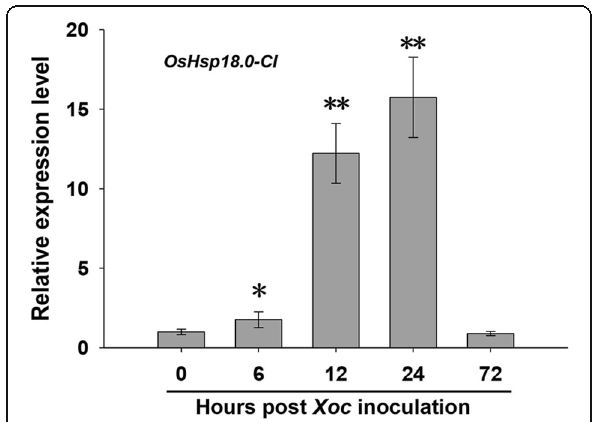
Fig. 1 OsHsp18.0-CI is induced by Xoc inoculation. The expression level of OsHsp18.0-CI in response to RS105 in Shengdao806 at 0, 6, 12, 24 and 72 h post inoculation. The bars represent the means (three replicates for gene expression) ± SD. The significance of expression compared to 0 h at P values of less than 0.05 and 0.01 are marked by “ * ” and “ ** ” ,